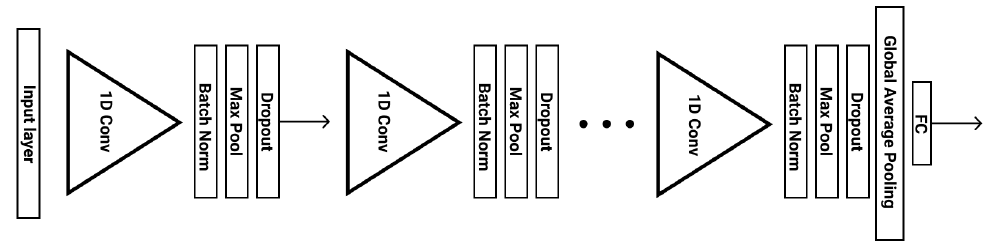
Figure 4. VGG inspired stress level analysis